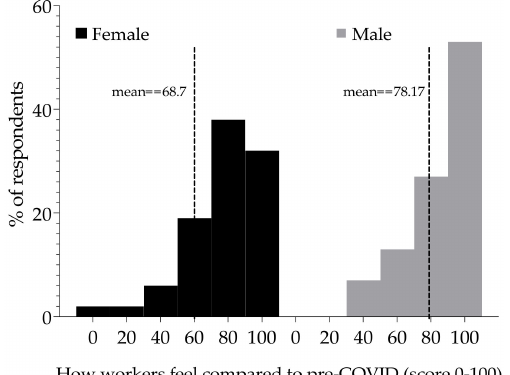
Figure 2. Health scores for respondents post-acute COVID-19 symptoms. Distribution of health scores (0–100) for female respondents ( n = 47) and male ( n = 15). Zero (0) to mean worst health and 100 best health. The separated (grouped) bars show the percentage of respondents that reported the scores. The vertical dashed lines indicate the mean scores for each